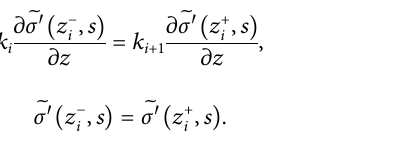
Frontiers in Earth Science |